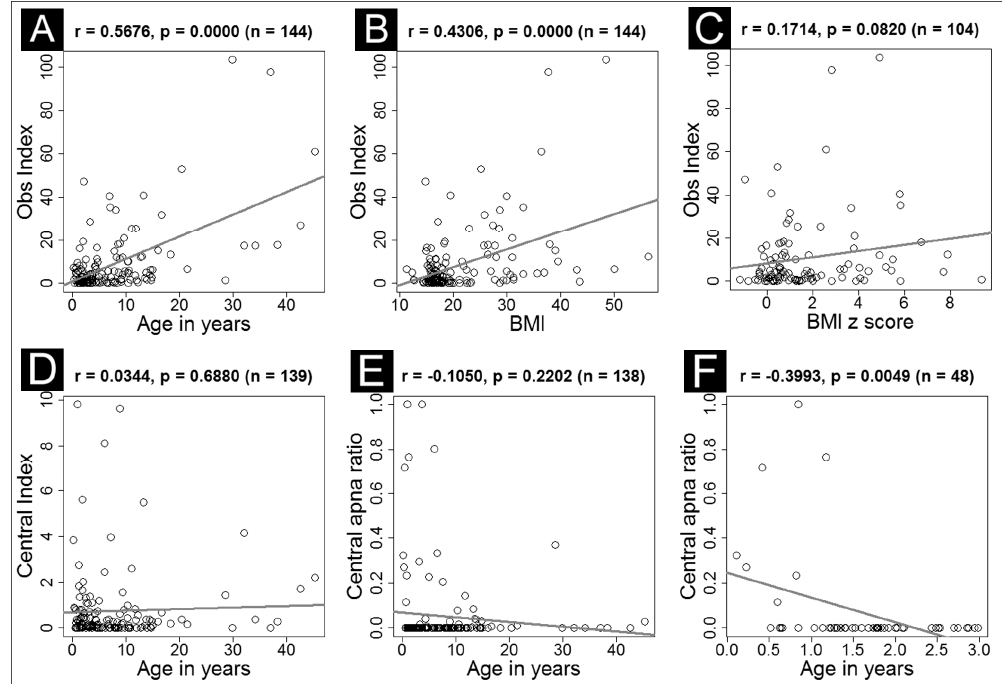
Figure 1. Correlation between obstructive apnea index and age ( A ) and BMI ( B ) and BMI z score ( C ). Correlation of central apnea index and age in all subjects ( D ); central apnea ratio and age in all subjects ( E ) and central apnea ratio and age in children ≤ 3 years ( F ). Pearson correlation coefficient ( r ), its associated p ‐ value ( p ), and the number of subjects ( n ) are listed in the header of each plot.